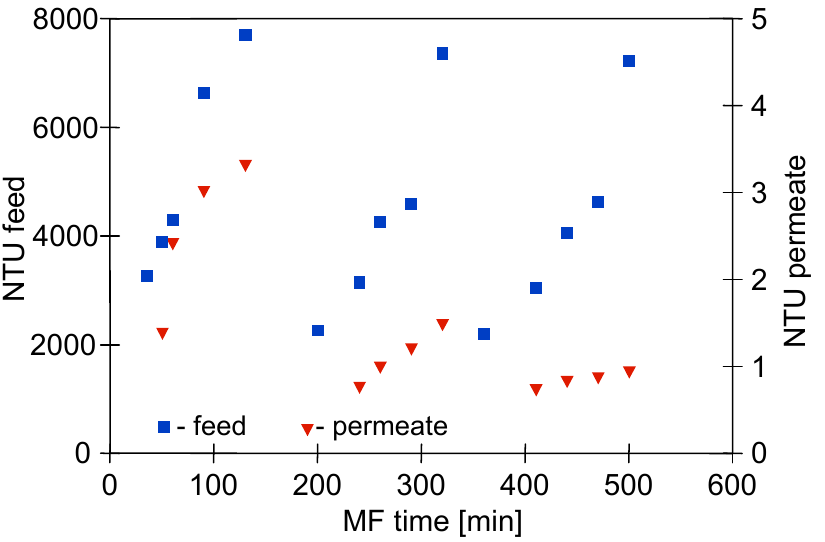
Figure 5. Changes in feed and permeate turbidity during MF of 1,3-PD fermentation broth with Citrobacter freundii . Module M1, TMP = 0.03 MPa, V F = 0.8 m/s.